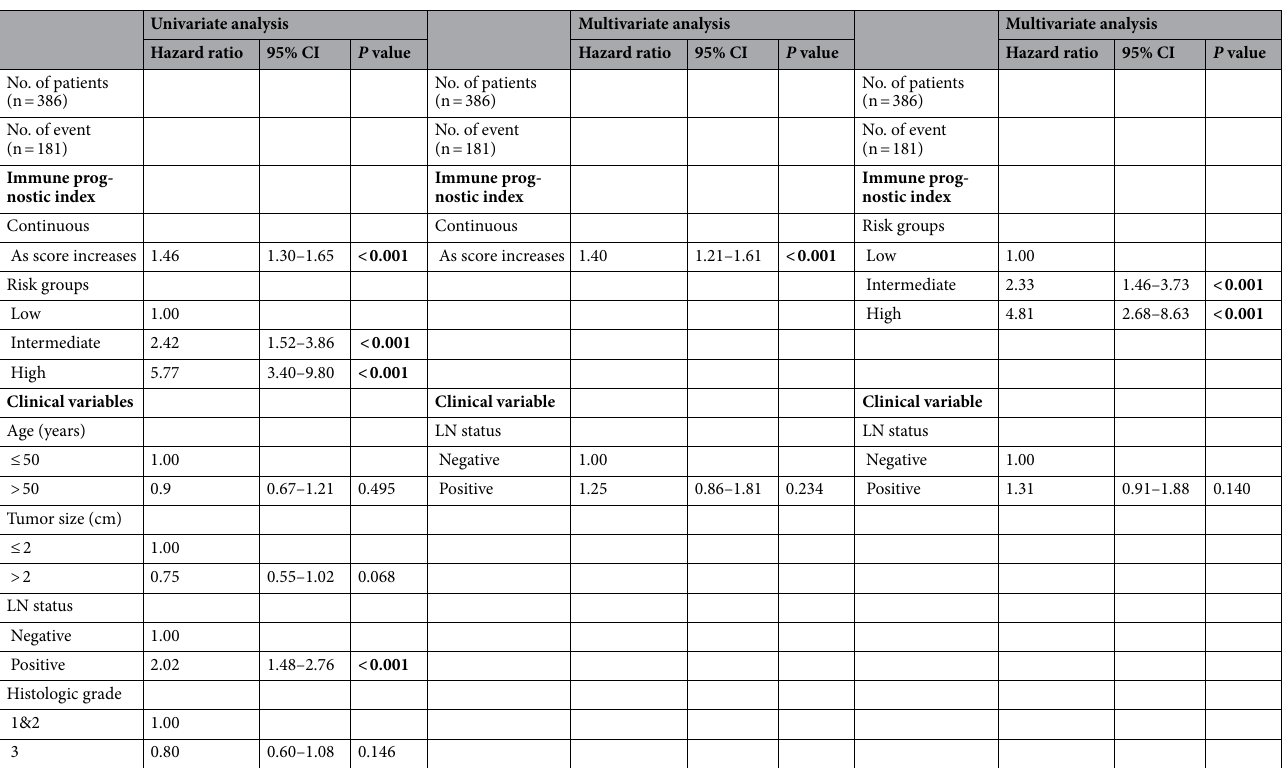
Table 3. Univariate and multivariate analyses of the immune prognostic index and clinicopathological variables in the discovery dataset. CI, confidence interval; LN, lymph node. P values < 0.05 are marked in